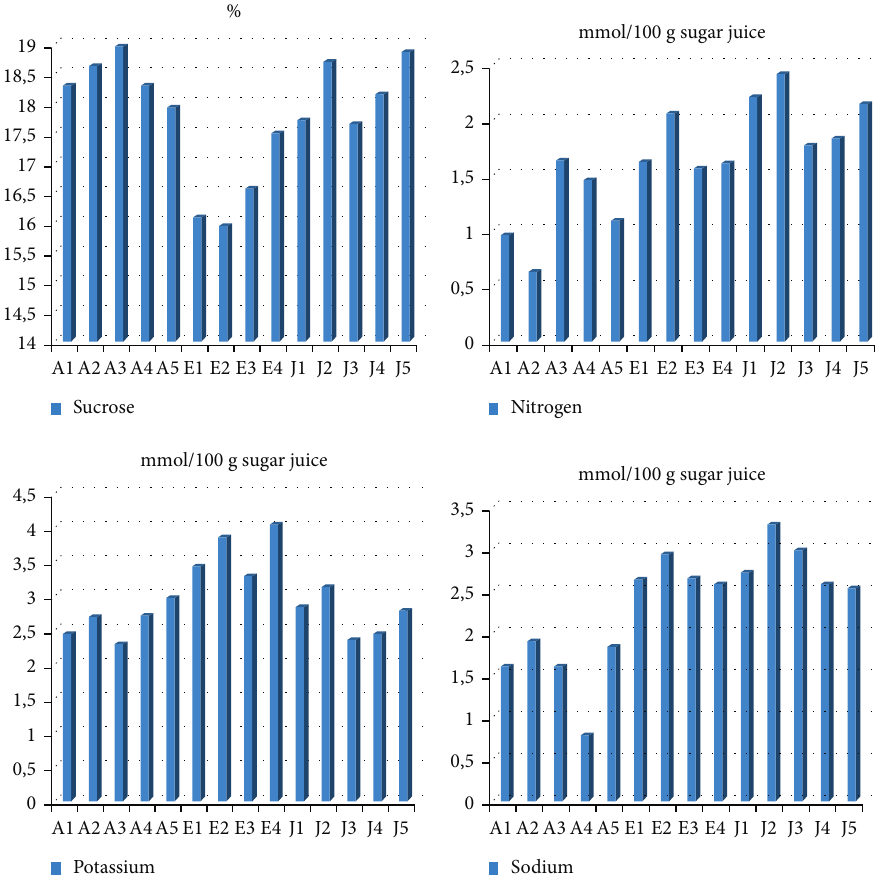
Figure 1: Sucrose, nitrogen, potassium, and sodium composition of beet in 3 harvest dates.